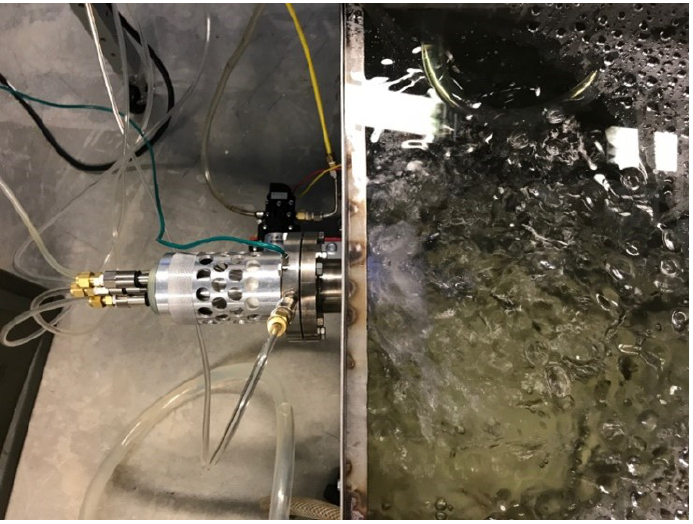
Figure 1. Operation of gliding arc plasmatron in a water tank during PAW production. System parameters are as follows. The water flow rate was 60 mL/min, the plasma air flow rate was 50 SLPM, the wall protection air was 24 SLPM, and the water atomization air was 51 SLPM. The experiment was performed using 1100 W plasma power. After PAW was generated, a chiller was used to cool the water down to 3–5 ◦ C. Temperature, conductivity, and pH were measured by a pH meter after cooling. The abundance of NO − H 2 O 2 was measured by test